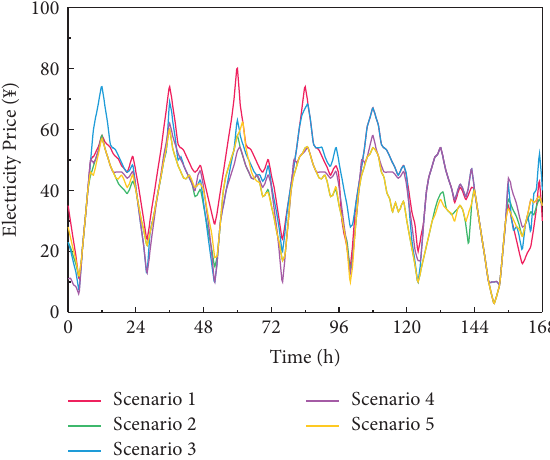
Figure 6: Electricity price in diferent scenarios. Table 2: Five diferent operation modes of VPP.